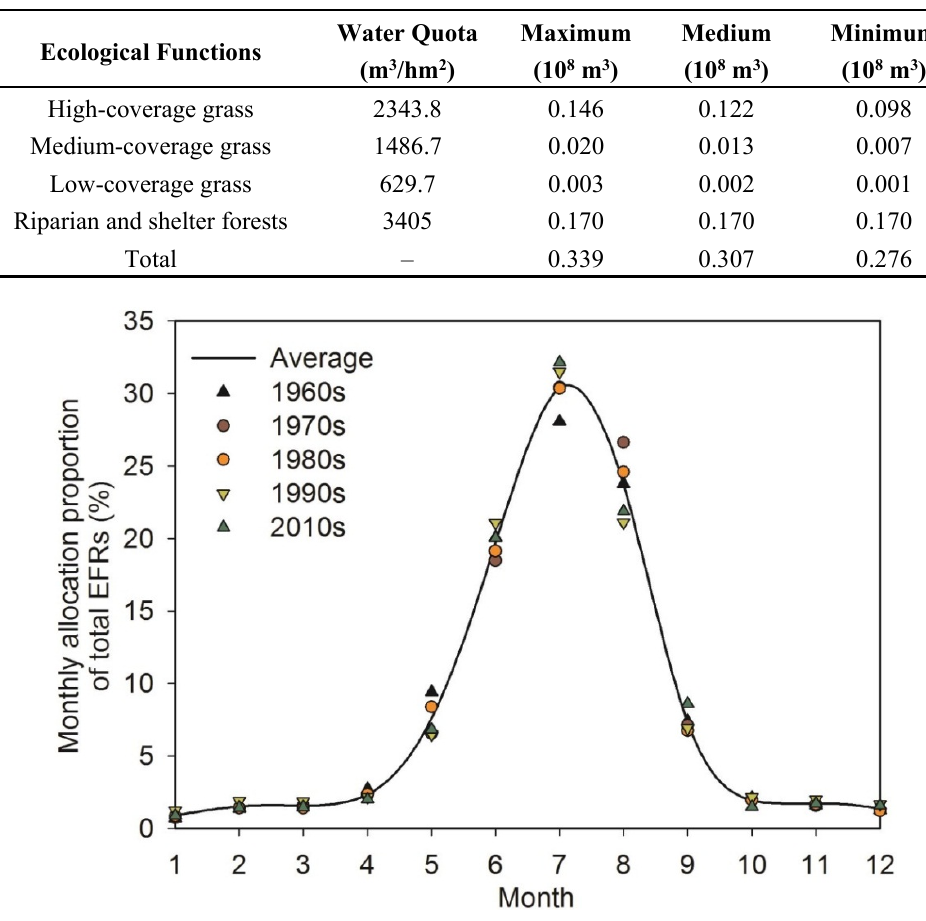
Table 3. Environmental flow requirements for natural oasis ecosystem based on different ecosystem functions.